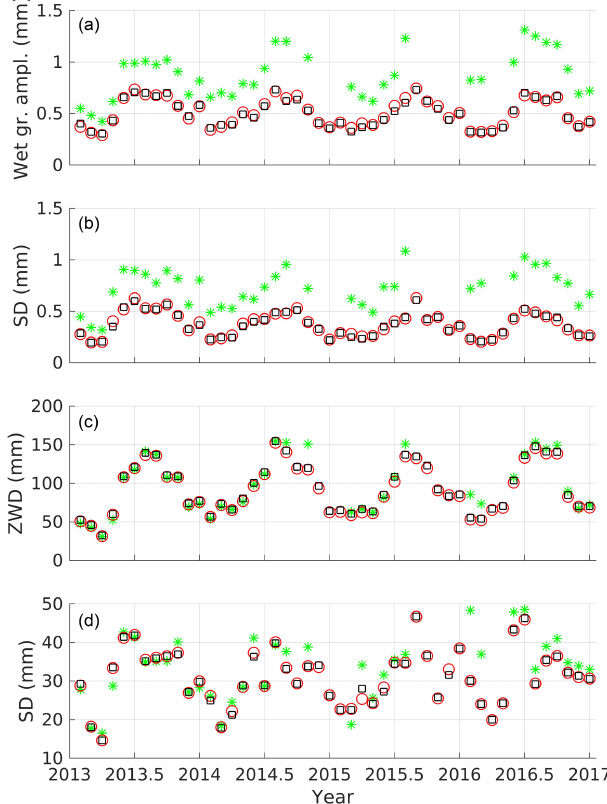
Figure 10. Time series of (a) monthly means of wet gradient ampli- q (cid:52) 2 e , wet + (cid:52) 2 n , wet ), (b) their SD, (c) monthly means of the tudes ( ZWD, and (d) the ZWD SD from GPS and WVR. The GPS results are from the 3 ◦ solution without weighting and the temporal reso- lution in the time series used to calculate the monthly mean and the SD is 15min. The green stars denote WVR data. The ONSA and ONS1 data are denoted by red circles and black squares, respec-